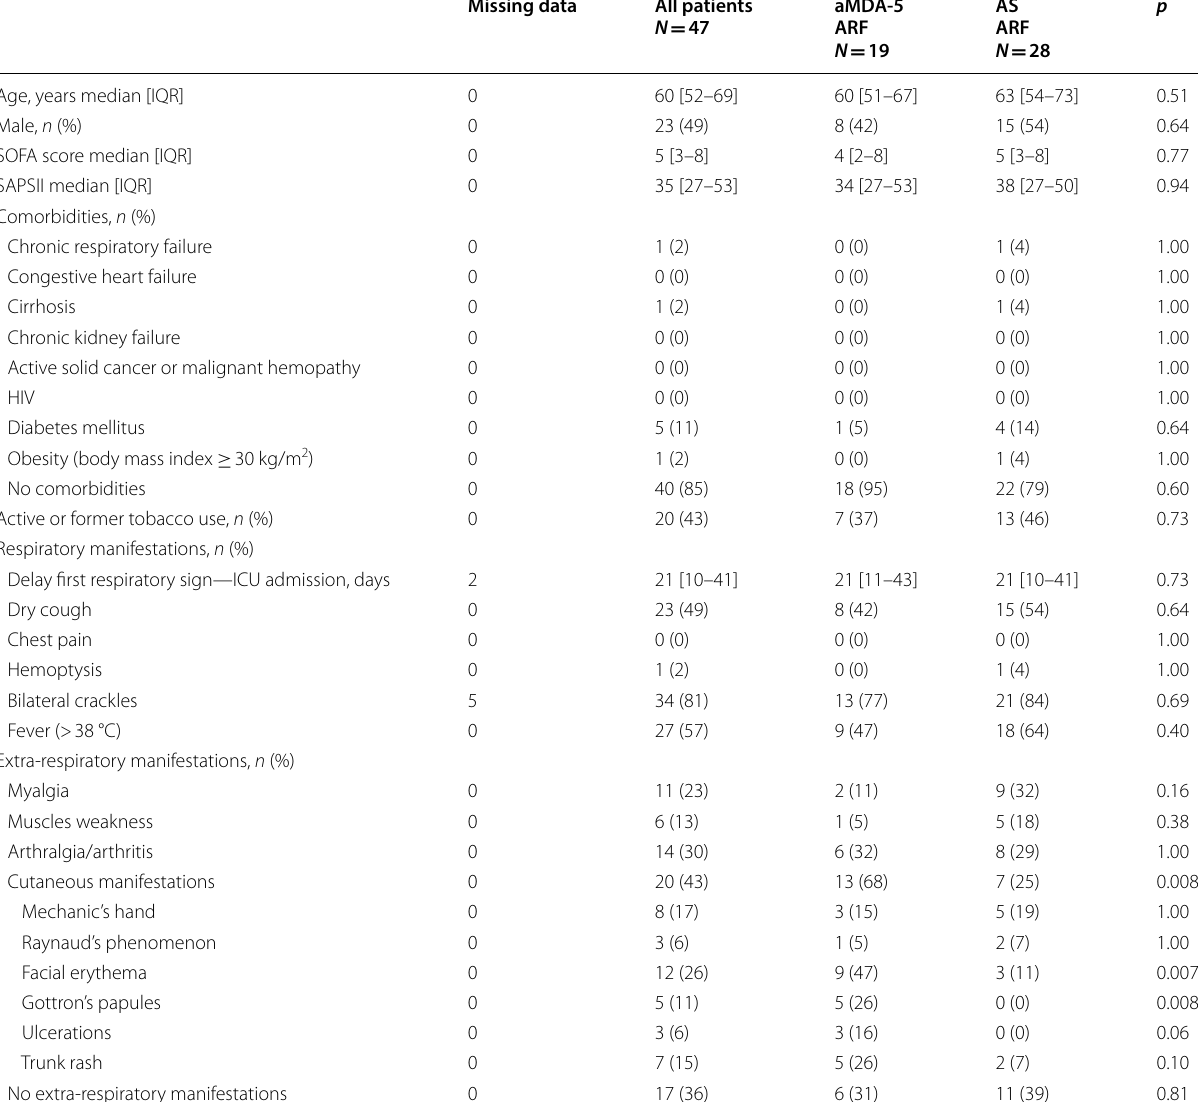
Table 1 Demographical and clinical manifestations of patients with acute respiratory failure revealing anti-synthetase syndrome or dermato-pulmonary syndrome associated with anti-MDA-5 antibodies Missing